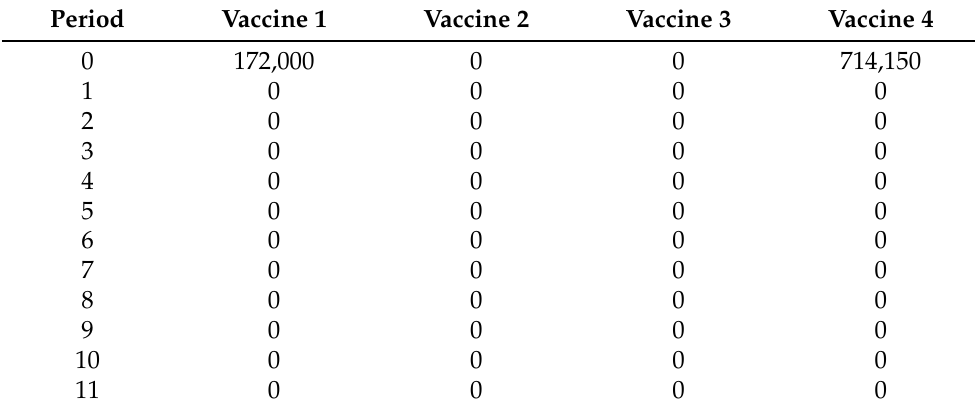
Table 8. Model PDPAHIT—District